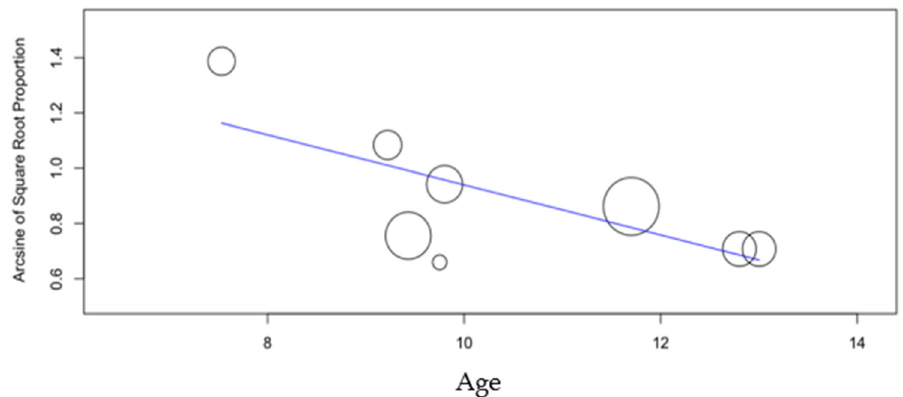
Figure A3. Meta-regression of age versus caries incidence for the control group.